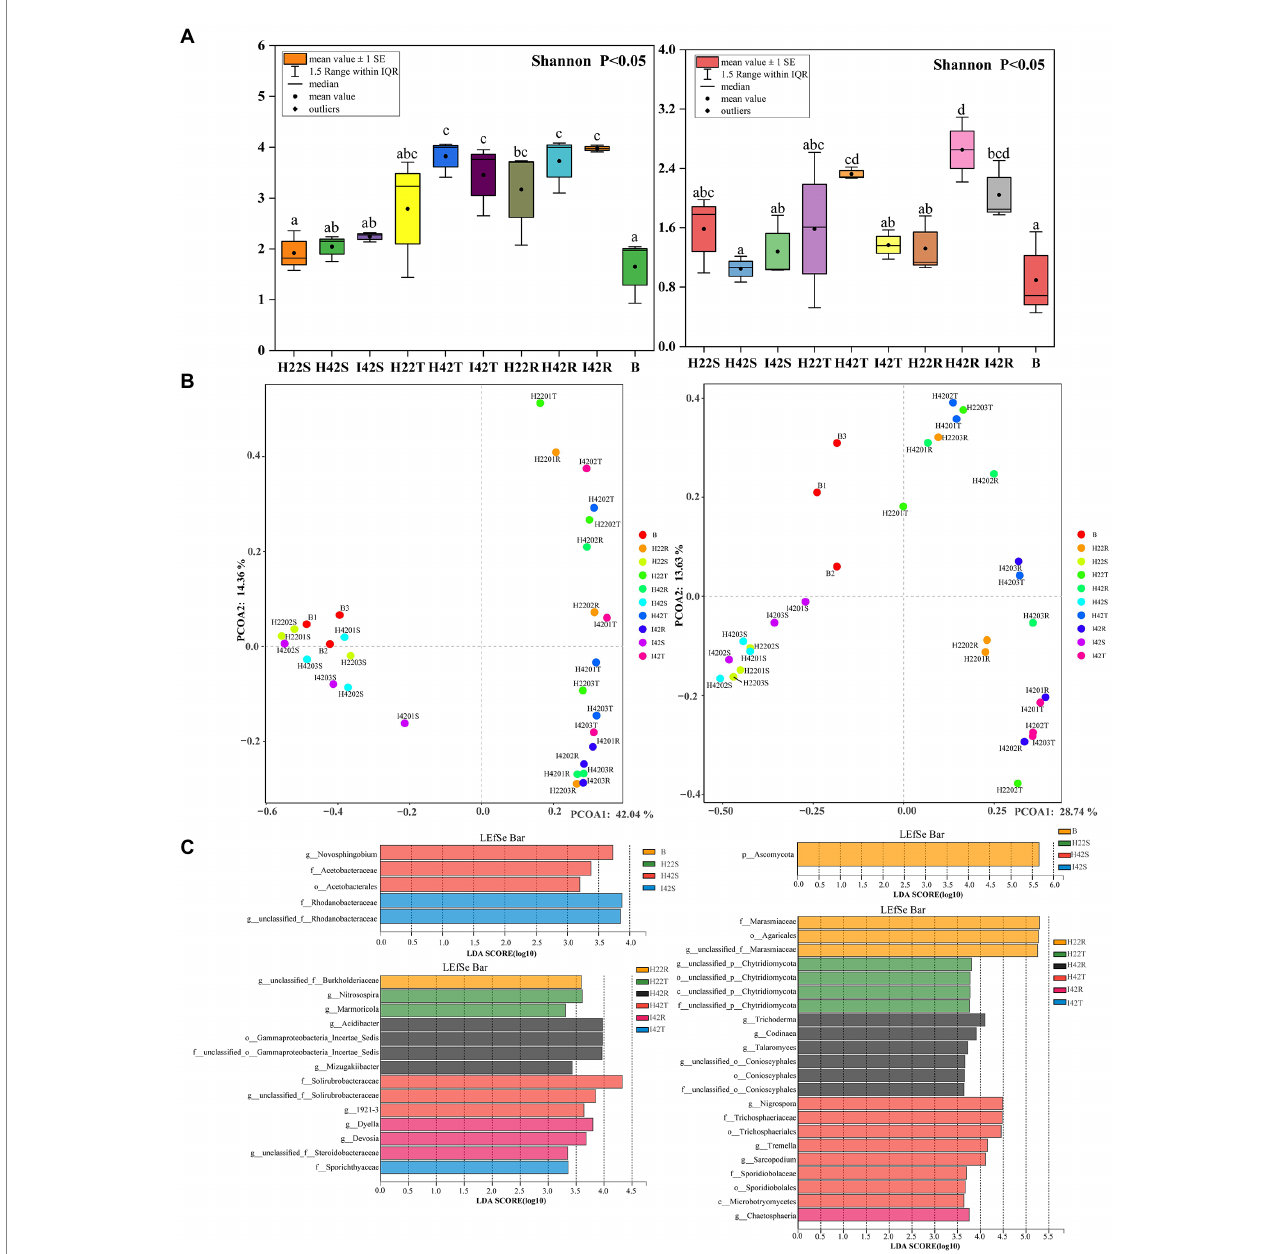
FIGURE 3 Bacterial (left side) and fungal (right side) differences between groups in alpha, beta diversity variance analysis and differential screening for Microbiome. (A) Figure of inter-group differences in alpha diversity of communities characterized at the level of microbiome genera. (B) Figure of PCOA of microbiome genus level characterized communities. Based on the obtained table of species diversity characteristics, the Shannon index and Simpson index were selected to calculate the richness and diversity of the community, and the Shannon index was used to plot the comparative differences between groups. PCOA analysis based on bray weighting algorithm. (C) (Top left side) Bacterial Microbiome with a significant role in sugarcane stems and herbivores. (top right side) Fungal Microbiome with a significant role in sugarcane stems and herbivores. (Lower left side) Bacterial Microbiome with a significant role in topsoil and rhizosphere soils. (Lower right side) Fungal Microbiome significant in topsoil and rhizosphere soils. LDA discriminant bar charts count the LDA scores obtained by LDA analysis (linear regression analysis) for multiple groups of microbial taxa with significant effects, with larger LDA scores representing greater effects of species abundance on differential